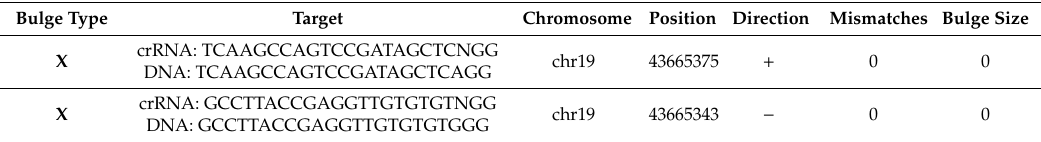
Table 1. O ff -target sites